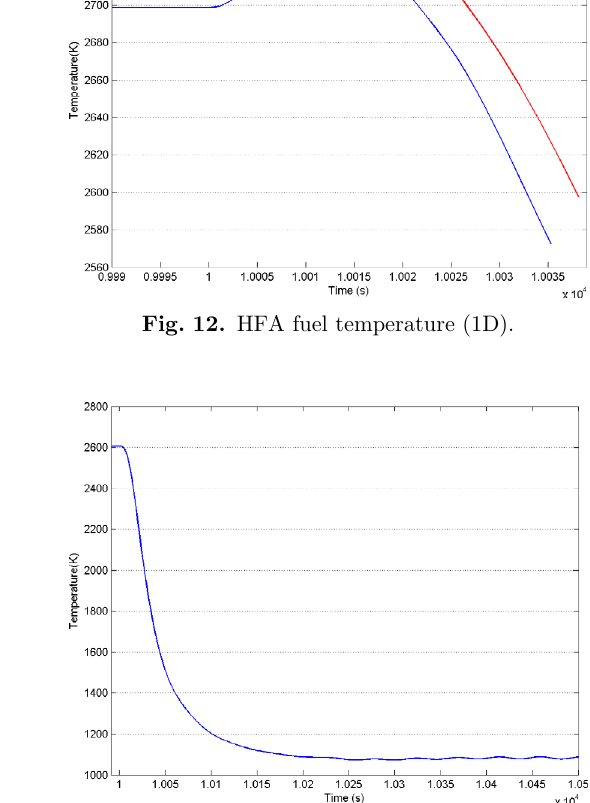
Fig. 13. Maximum fuel